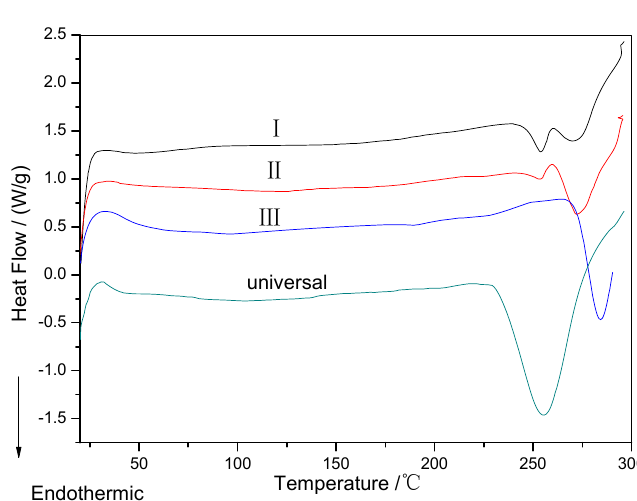
Figure 2. DSC curves of foam